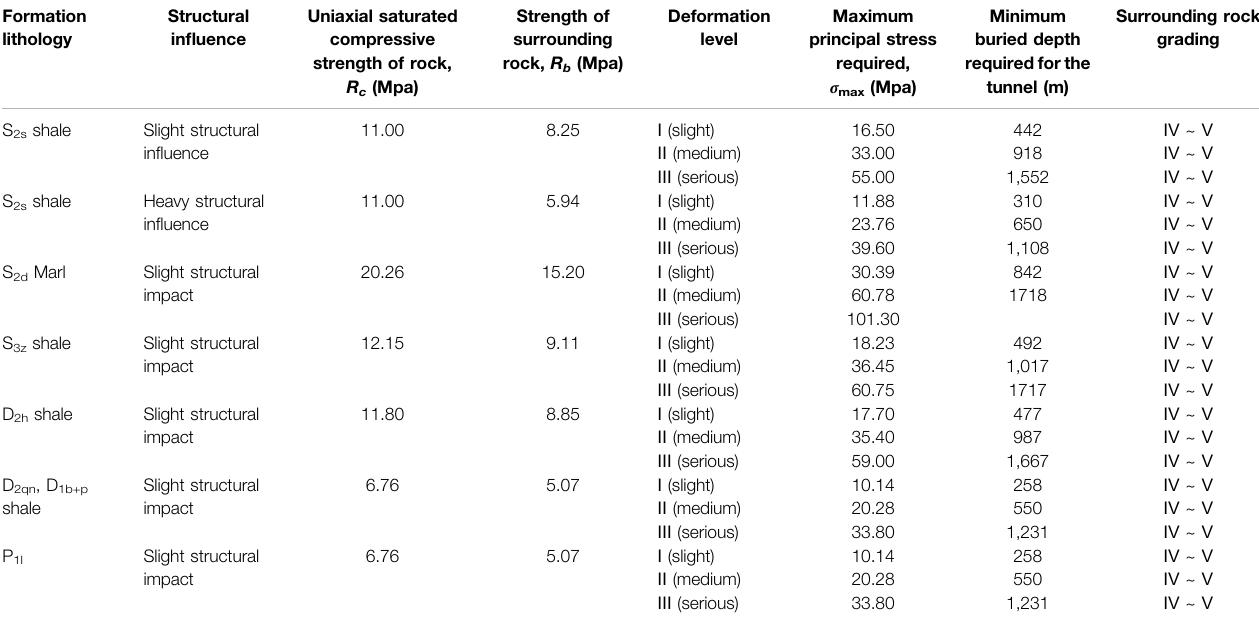
TABLE 3 | Buried depth required for large deformation of soft rock in various stratum lithology.